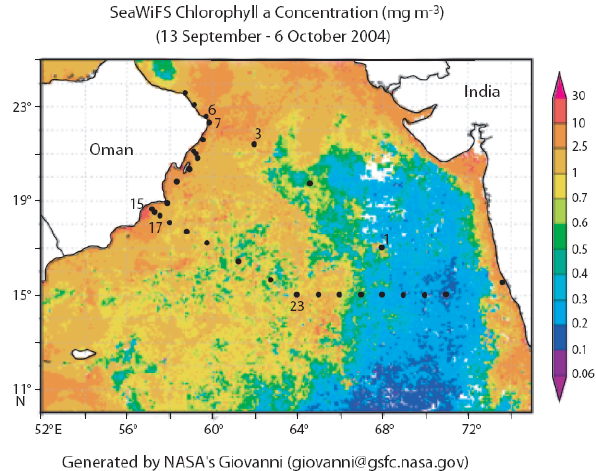
Composite SeaWiFS chl- a image for 13 September– 6 October 2004 (source: http://reason.gsfc.nasa.gov/OPS/Giovanni/ ocean.swf8D.shtml) corresponding to the Muscat-Goa leg of Cruise SK209 with superimposed station